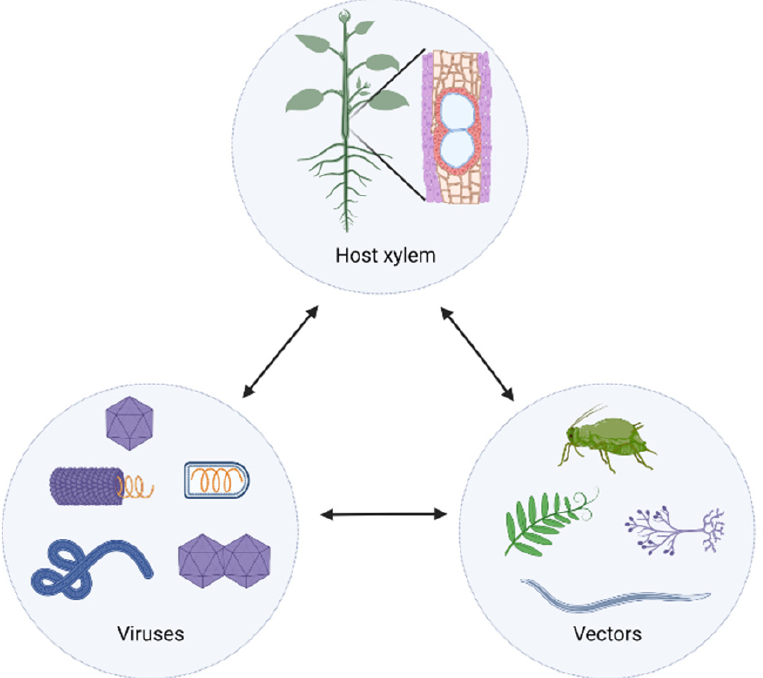
Figure 1. The interaction triangle depicting the interactions between viruses, vectors, and plant host xylem. The double arrowed lines stand for bidirectional interactions. The host xylem circle shows leaf, stem, and root xylem from both the herbaceous and perennial plants. The virus circle encompasses the xylem-invading viruses with different shapes and genome organization. The vector circle comprises the insects, fungi, parasitizing weeds, and nematodes. Figures were created with Biorender.com.